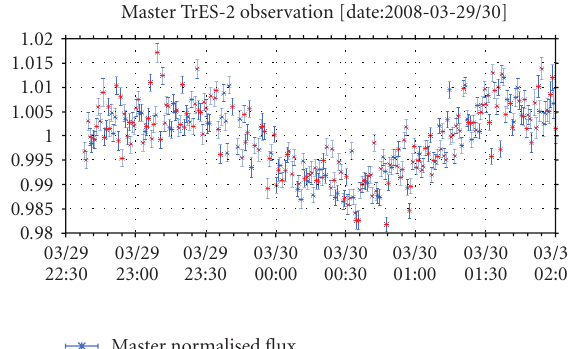
Figure 1: Folow-up exoplanet transit observations by MASTER (Moscow).